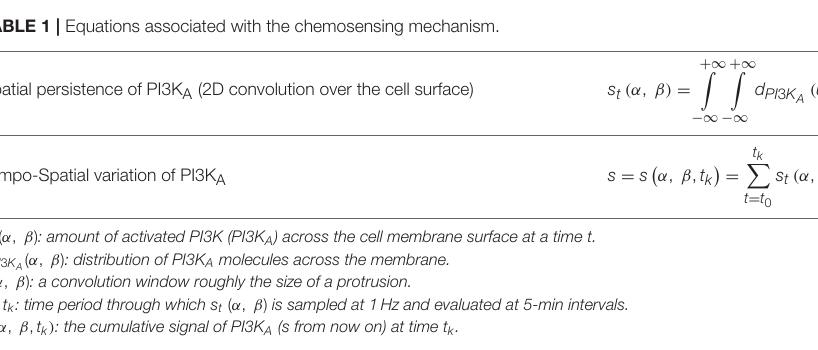
TABLE 1 | Equations associated with the chemosensing